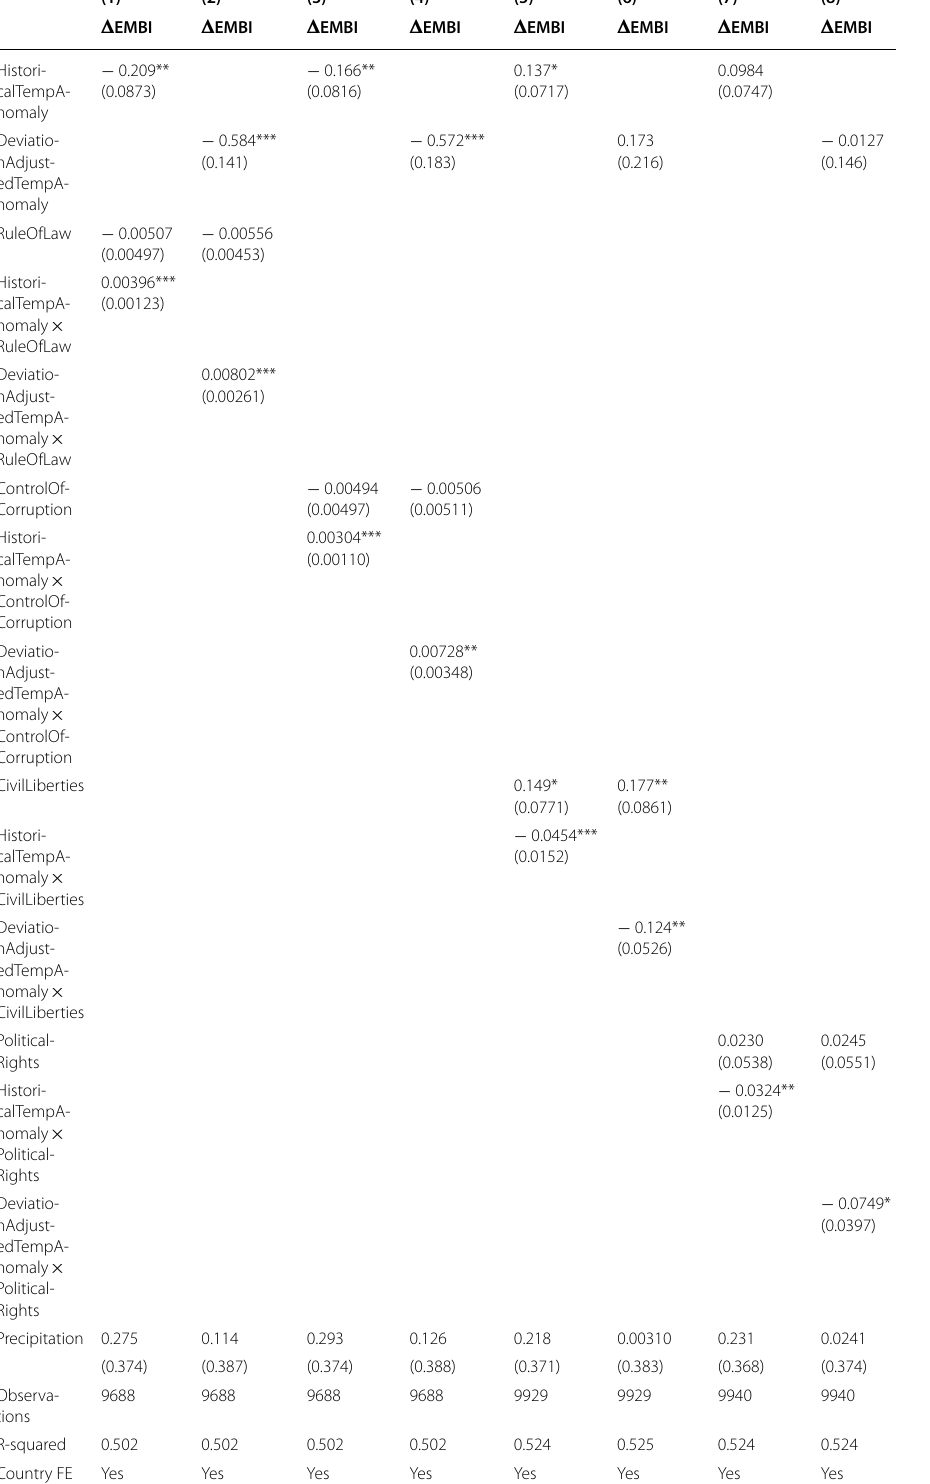
Table 9 Channels of temperature–sovereign risk connection: institutional